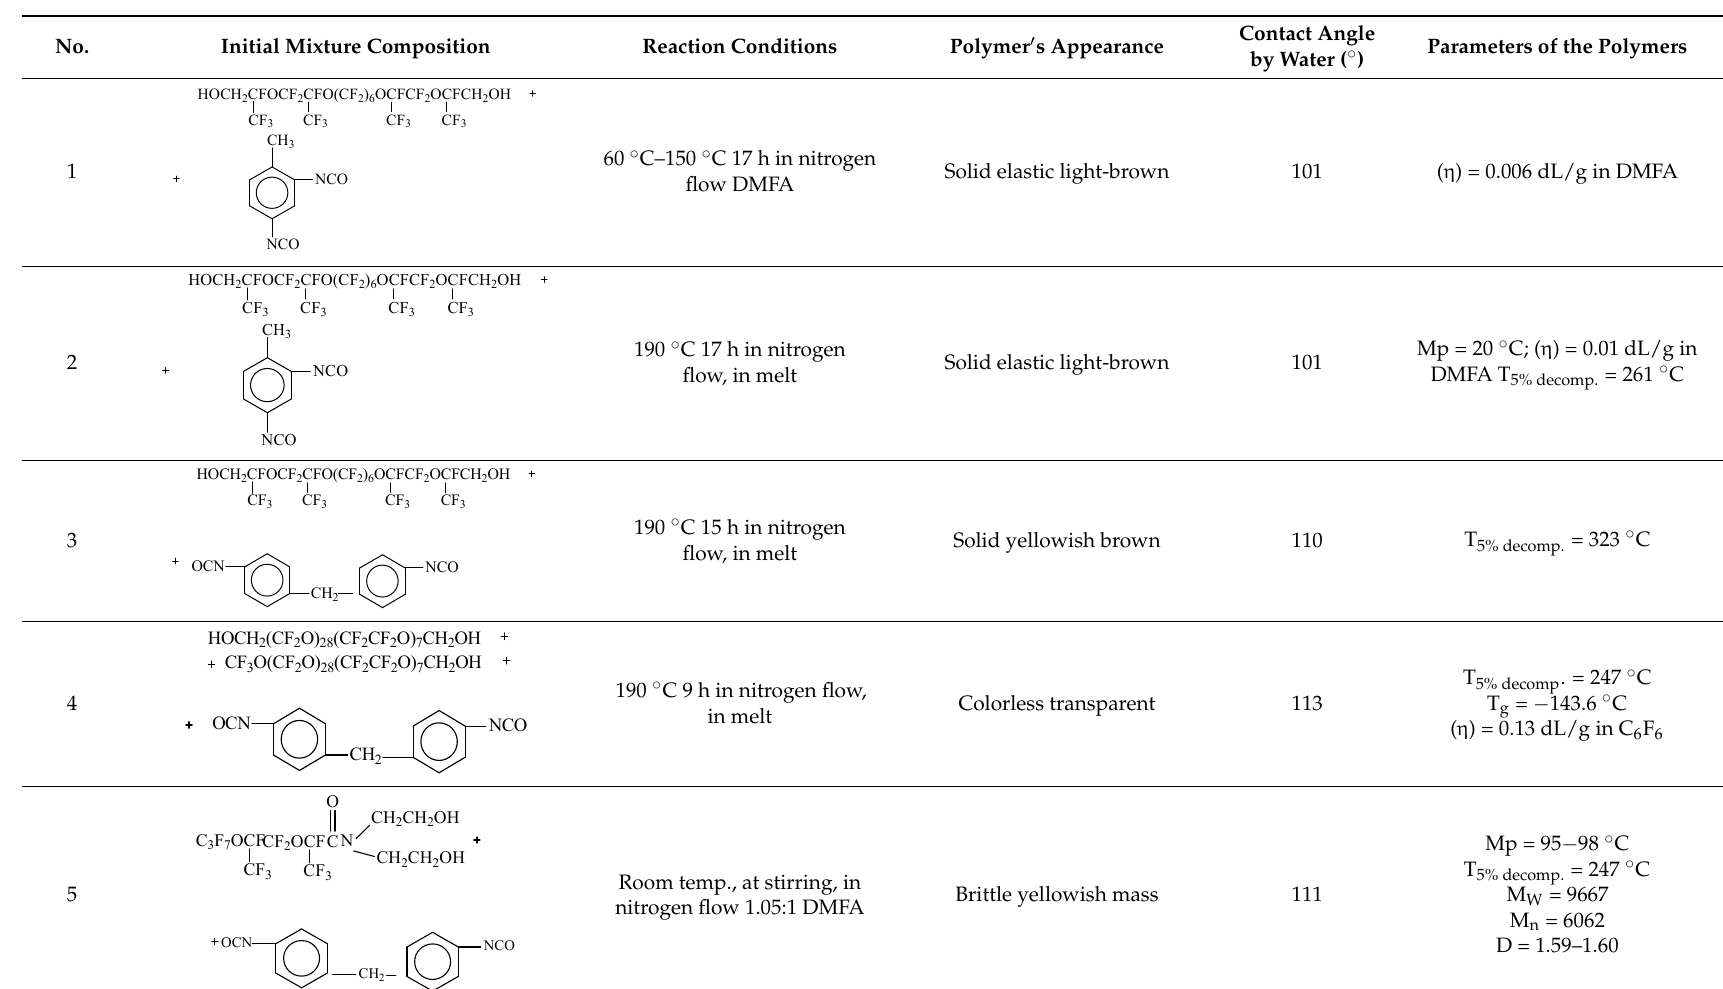
Table 1. Fluoropolyurethane synthesis conditions and some parameters of the prepared polymers.